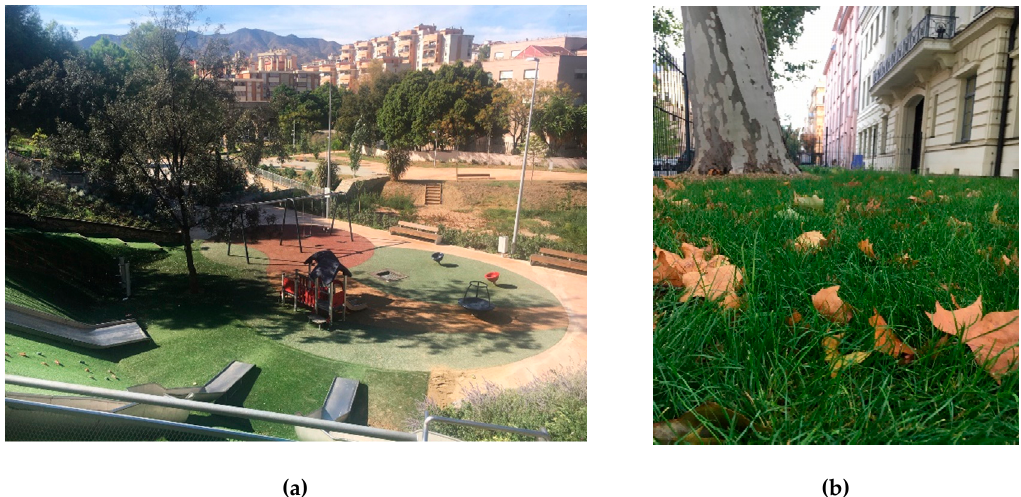
Figure 9. Synthetic (plastic) lawns in a playground in Malaga (Spain) ( a ), and front yard of a residential building in Leipzig (Germany) ( b ). Photos: D. Dushkova.